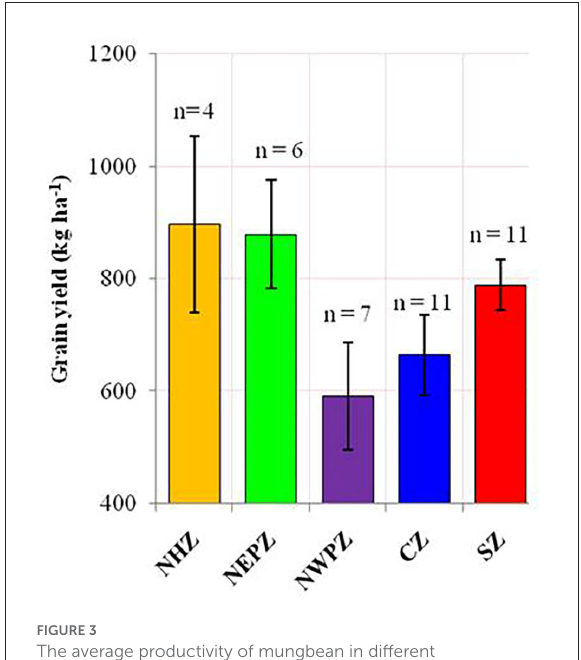
FIGURE3 The average productivity of mungbean in different agroecological regions of India. The error bar represents the standard error of means. North Hill Zone (NHZ), North Eastern Plain Zone (NEPZ); North Western Plain Zone (NWPZ); Central Zone (CZ); South Zone